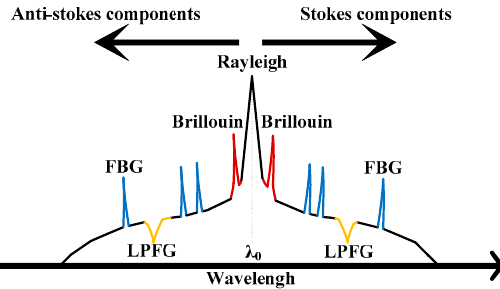
Figure 2. The spectral distribution of the hybrid BOTDA/XFG sensing technique.